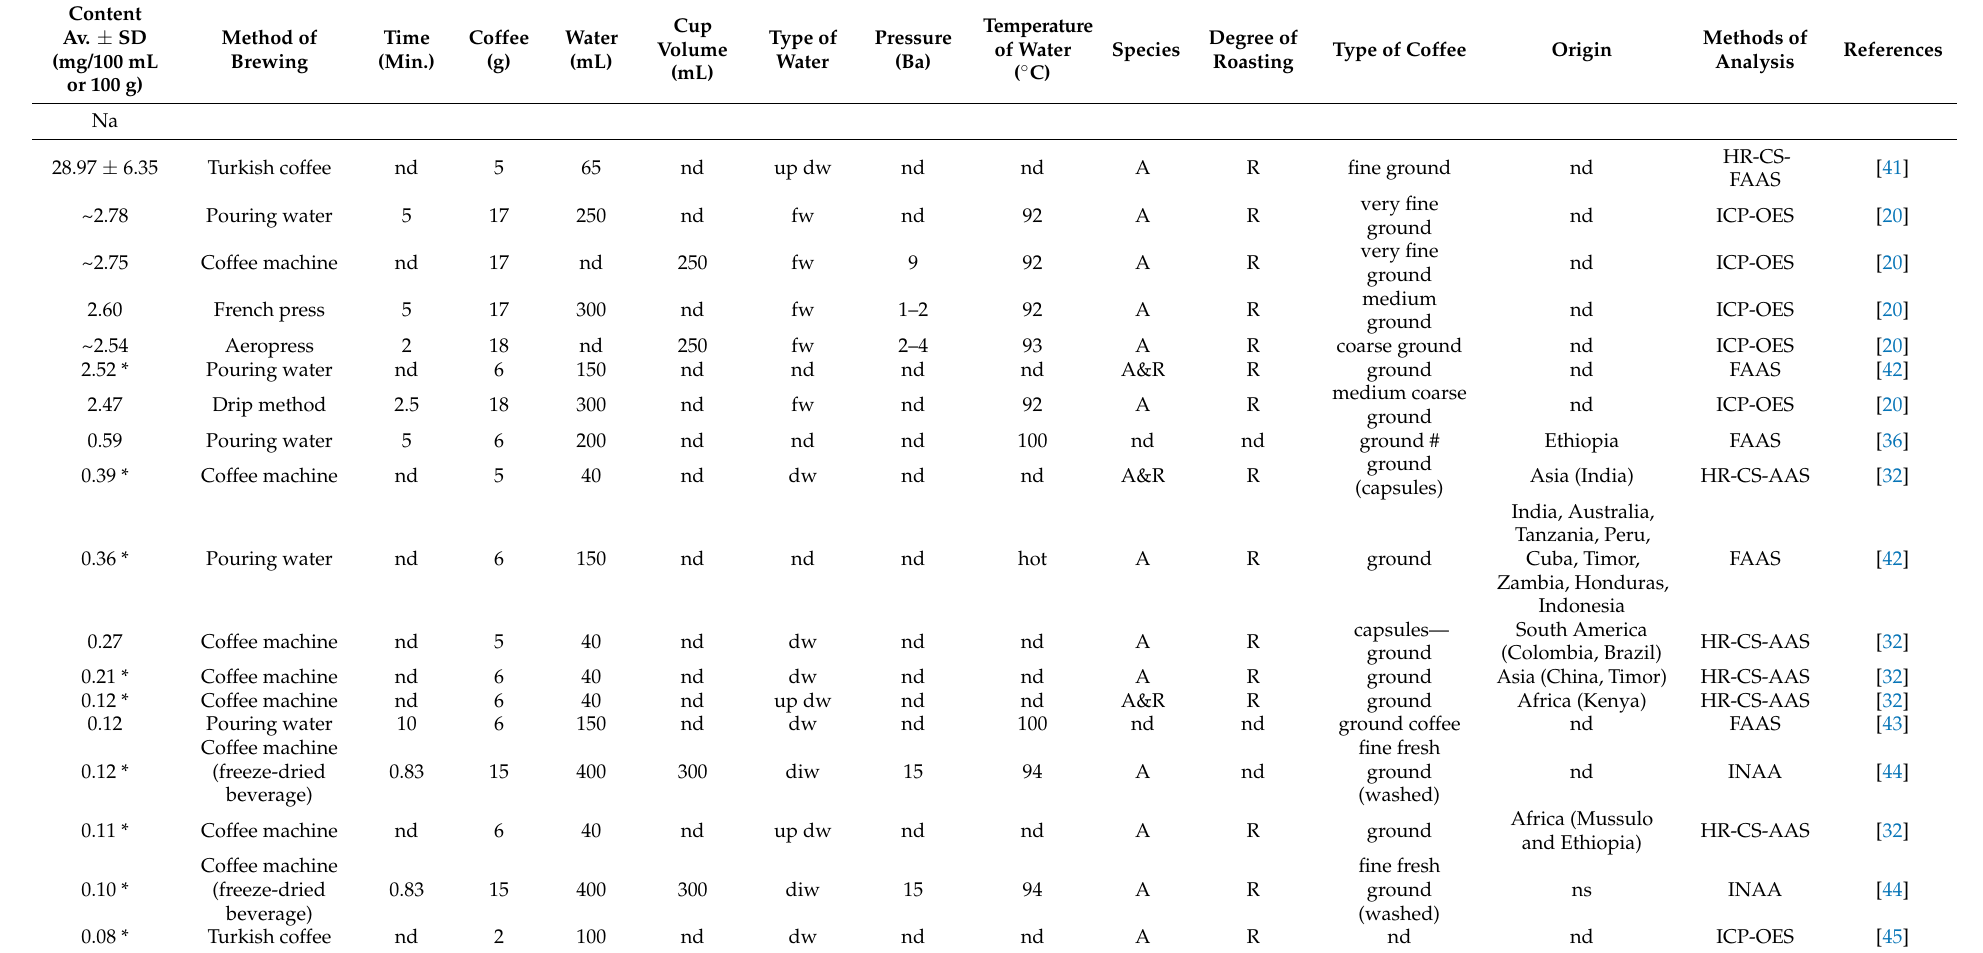
Table 1. The content of macroelements per 100 mL of coffee